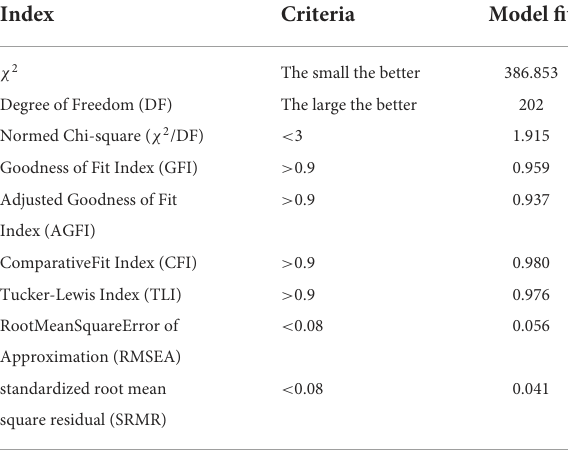
TABLE 10 Model fit criteria and the test results ( n =